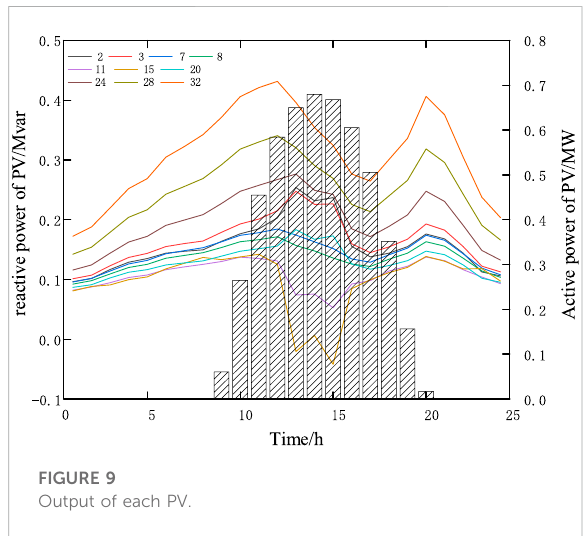
FIGURE 9 Output of each